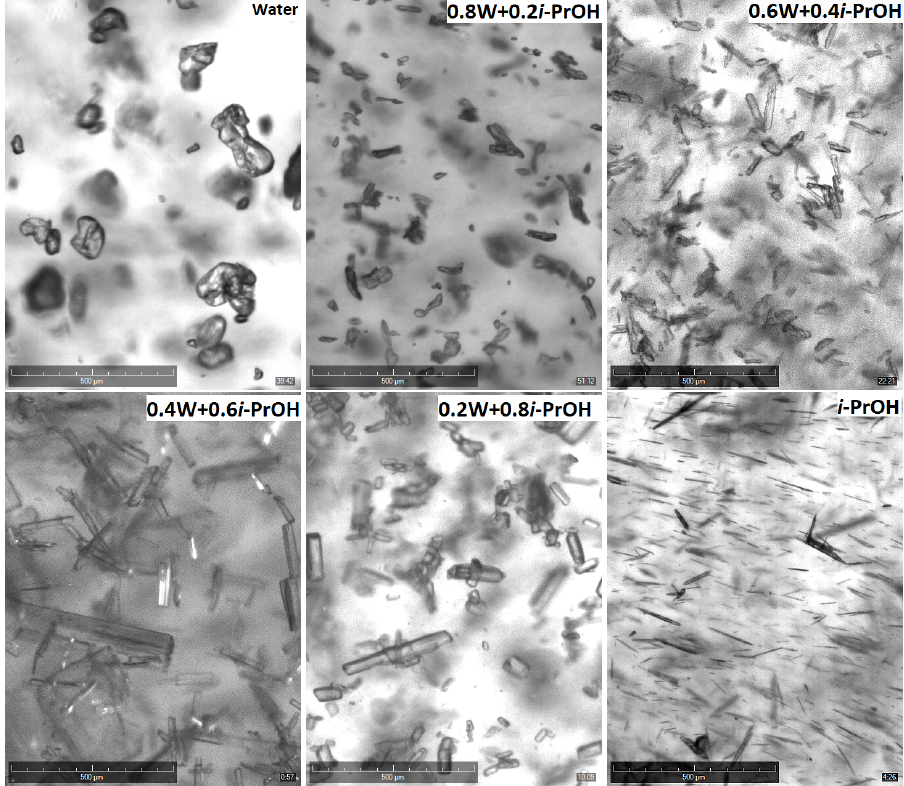
Figure 13. Images of ascorbic acid crystals in water-iso-propanol solvent systems (scale: 500 µ